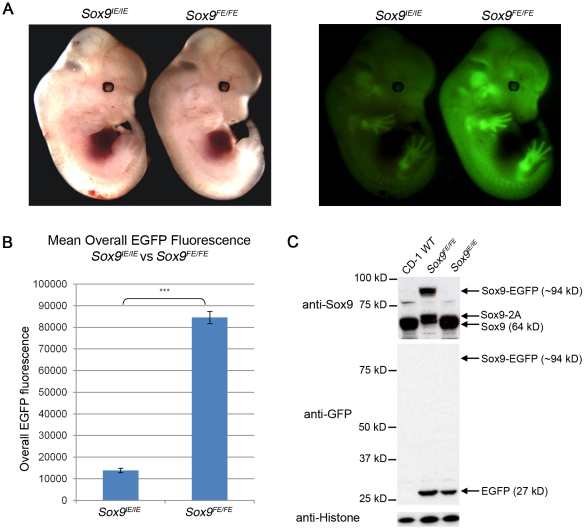
Comparison of E12.5 Sox9IE/IE and Sox9FE/FE embryos based on EGFP intensity and Western blotting.(A) Left panel: white light images of E12.5 Sox9IE/IE and Sox9FE/FE embryos; right panel: same embryos imaged by fluorescence microscopy showed a higher EGFP fluorescence in the Sox9FE/FE embryo compared to the Sox9IE/IE embryo, with EGFP expression in Sox9-specific domains in both. (B) Mean overall EGFP fluorescence of E12.5 Sox9IE/IE (13880.04±1015.55; n = 8) and Sox9FE/FE (84579.48±2822.09; n = 4) embryos analyzed by flow cytometry. Overall EGFP fluorescence was calculated by multiplying the MFI and percentage of EGFP-positive cells. Two-tailed Student's T test, ***p<0.0001. (C) Western blot analysis of E12.5 Sox9IE/IE and Sox9FE/FE embryo lysates, resolved on SDS-polyacrylamide gel electrophoresis (SDS-PAGE) gels and immunoblotted with anti-Sox9 (upper panel) and anti-GFP (middle panel) antibodies. In the upper panel, Sox9-EGFP fusion protein and Sox9-2A (2A - residual 23 amino acids of F2A) was only detected in the Sox9FE/FE embryo lysate, but not in the CD-1 WT or Sox9IE/IE embryo lysates. Middle panel: Sox9-EGFP fusion protein was not detected in the Sox9FE/FE embryos but EGFP was detected in both the Sox9IE/IE and Sox9FE/FE lysates at predicted molecular weight. CD-1 WT lysate served as negative control for EGFP. Bottom panel: immunoblotting with anti-histone antibody showed equal loading. WT – wild-type.